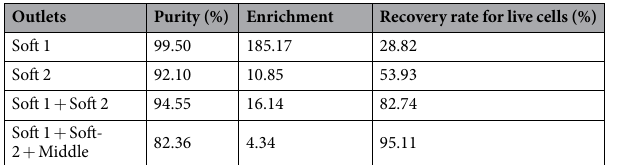
Outlets Purity (%) Enrichment Recovery rate for live cells (%)